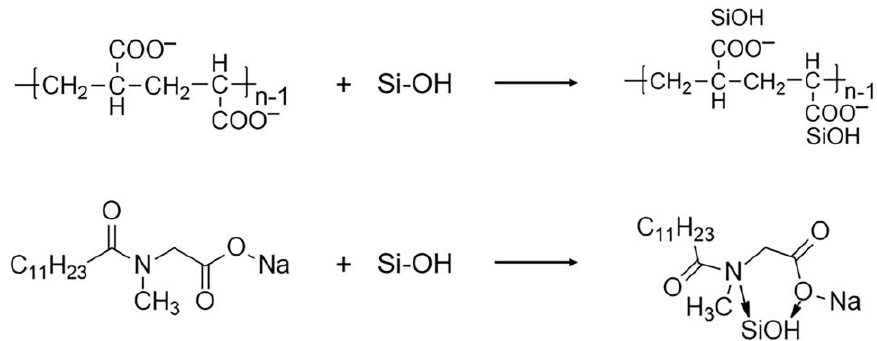
Figure 9. ( a ) Potassium pyrophosphate ion morphology distribution, ( b ) FTIR result of the slurry before and after polishing.